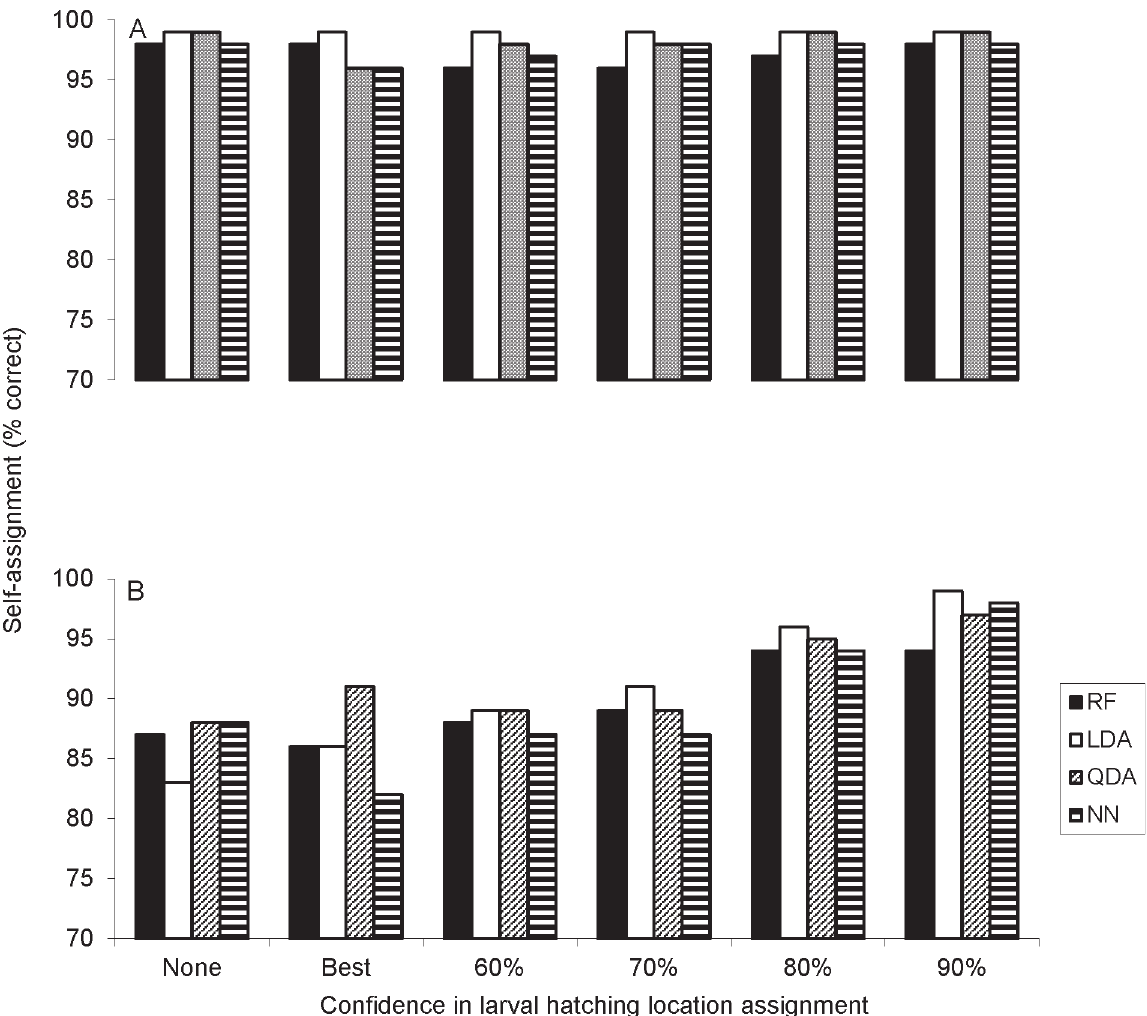
Fig 4. Larval yellow perch self-assignment results using a Random Forest (RF), Linear Discriminant Function Analysis (LDA), Quadratic Discriminant Function Analysis (QDA), and Neural Network (NN) based on otolith microchemistry data for a) 2006 and b) 2007. A total of N = 47 and N = 71 larvae were analyzed in 2006 and 2007. Confidence in hatching locations is as follows: None = null assignments based on capture location (i.e., no backtracking used); Best = larvae assigned to single most likely hatching location (SS or NS) based on backtracking; and 60, 70, 80, 90 = larvae assigned to hatching location after backtracking revision with 60, 70, 80, 90% levels of certainty in hatching origin,